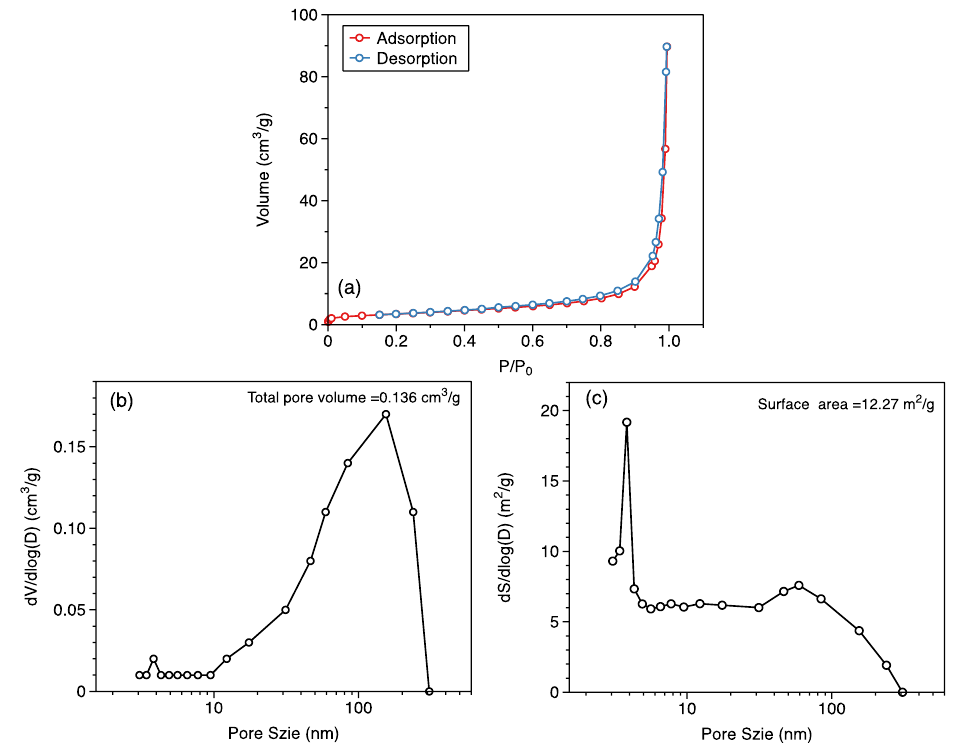
Figure 1. Adsorption/desorption curves ( a ), pore volume ( b ), and pore surface ( c ) distribution obtained by LT-N2 A/D for kaolinite KGA-1b clay mineral.